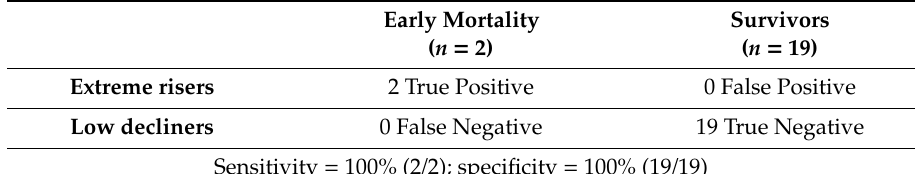
Table 3. Sensitivity and specificity of two-group exosomal UCH-L1 model for predicting early